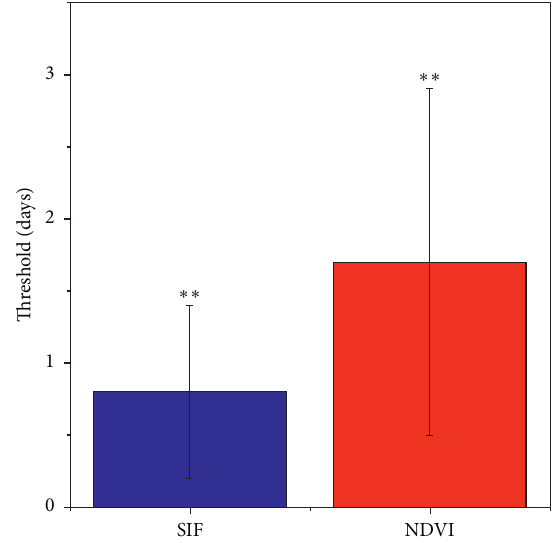
Figure 7: The threshold of the number of days that indicated NDVI/SIF change percent changed from a positive value to a negative value, derived from NDVI and SIF during 2008–2014. The threshold days were calculated from the linear fit between the averaged NDVI/SIF change percent and the bins of SHI heat wave anomalies (as depicted in Figure 6). ∗∗ indicates that P < 0 . 01 (note that the unit of the threshold in this figure is days per year, which differs from the unit in the above figures (days per 10